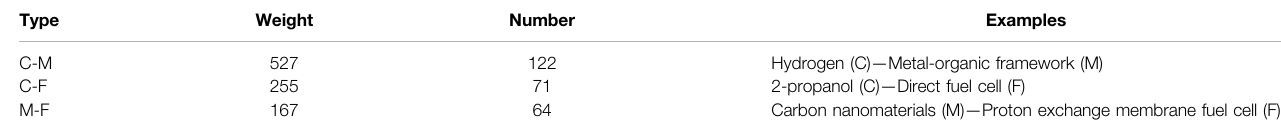
TABLE 2 | Weights of different types of edges.